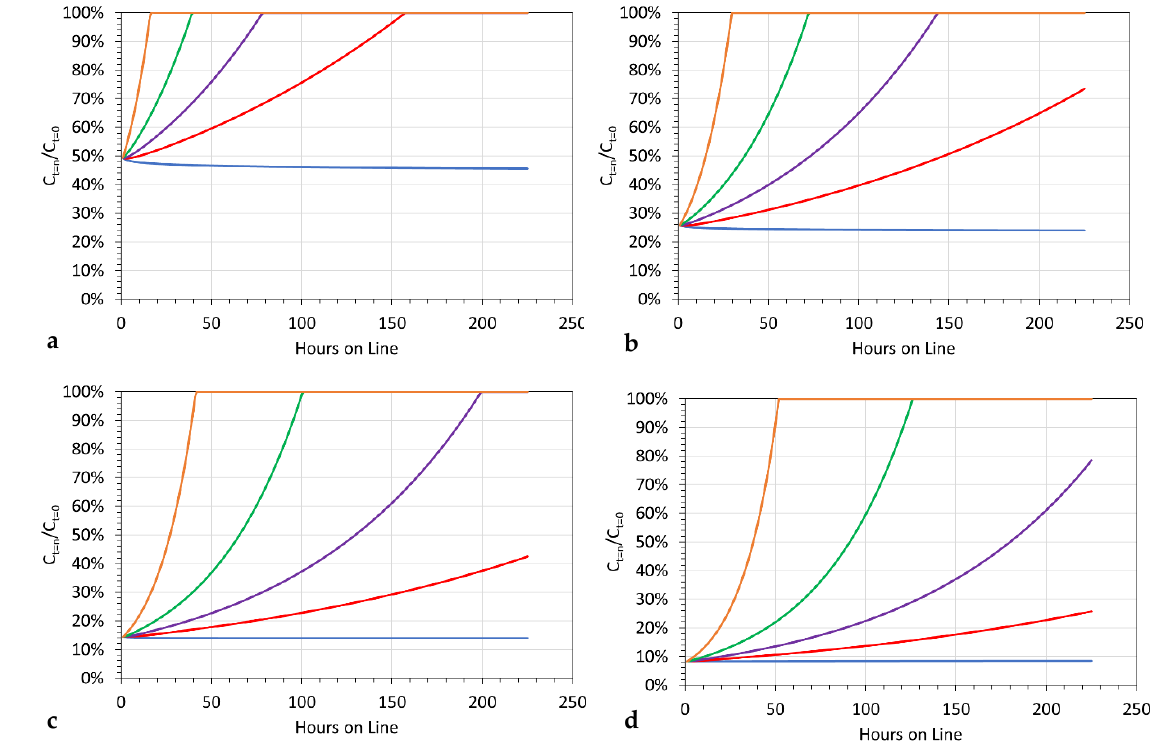
Figure 18. Fe@Ca@urea polymer product water salinity versus hours on line ( t r ). Assumptions. Process flow: Figure 13; R r = 90%; 100% of the polymer recovered from the product water is returned to the reactor. t r = time between entering the reactor and leaving the separator. [d] = 1: blue; [d] = 1.005: red; [d] = 1.01: purple; [d] = 1.02: green; [d] = 1.05: orange; ( a ), P w = 1.4 g FeSO 4 L − 1 +